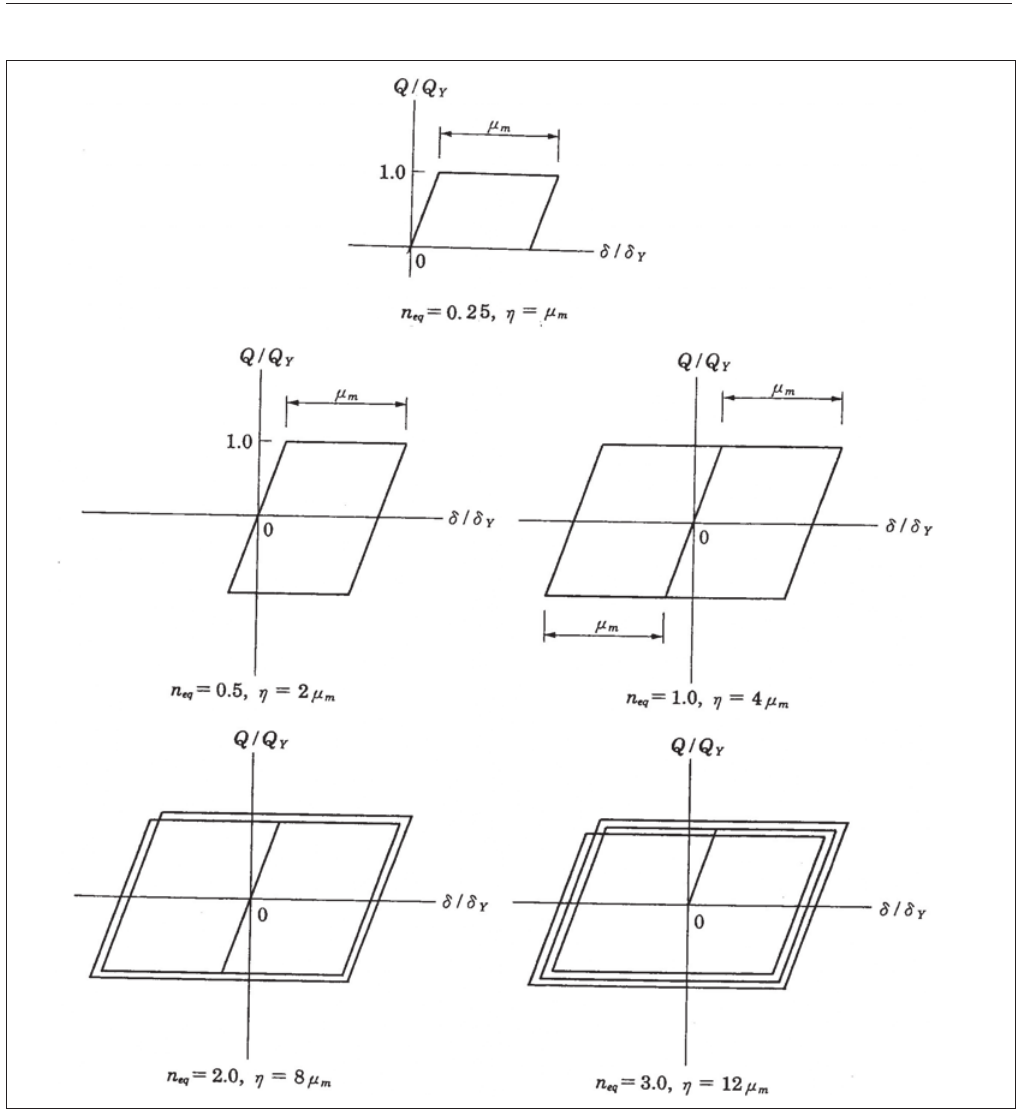
Fig. 5. Equivalent hysteretic loop associated with η / µ